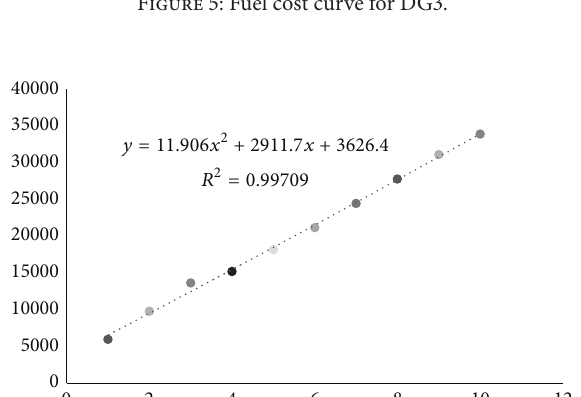
Figure 5: Fuel cost curve for DG3.